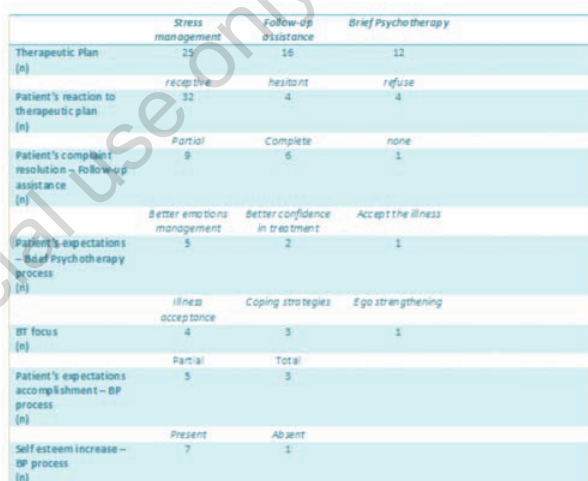
Table 2. Main events identified during pilot implementation - part